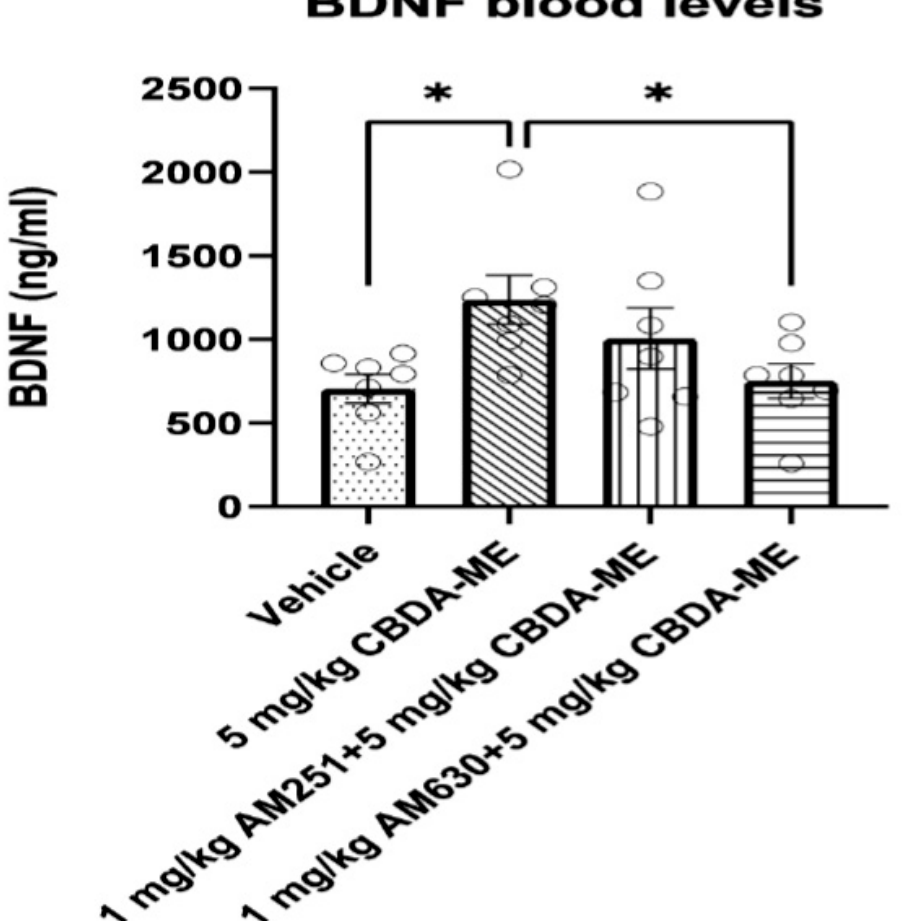
Figure 6. BDNF blood level (mean + SEM) of female WKY rats. Rats received either vehicle (n = 7) or 5 mg/kg CBDA-ME (n = 7), 1 mg/kg AM251 + 5 mg/kg CBDA-ME (n = 7), 1 mg/kg AM630 + 5 mg/kg CBDA-ME (n = 7). * p < 0 .05.